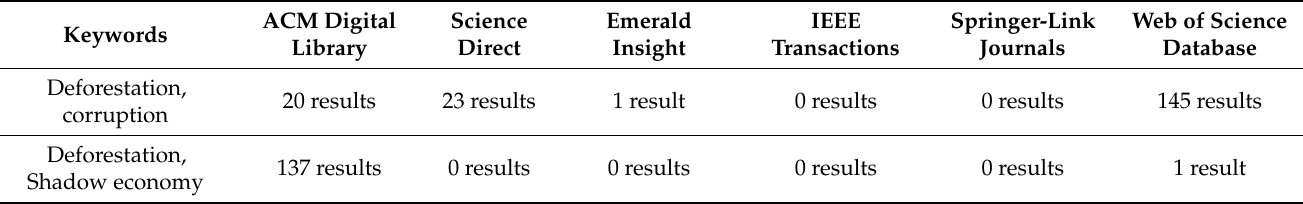
Table 1. Academic research on deforestation in respect with corruption and shadow economy—number of results adjusted by keywords and